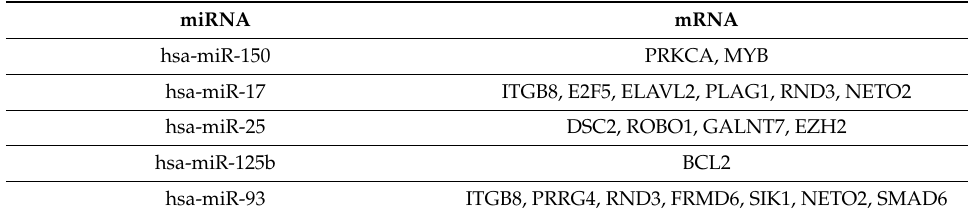
Table 8. miRWalk (miRTarBase, TargetScan and miRDB filters) database showed interactions between 5 DEmiRNAs and 17